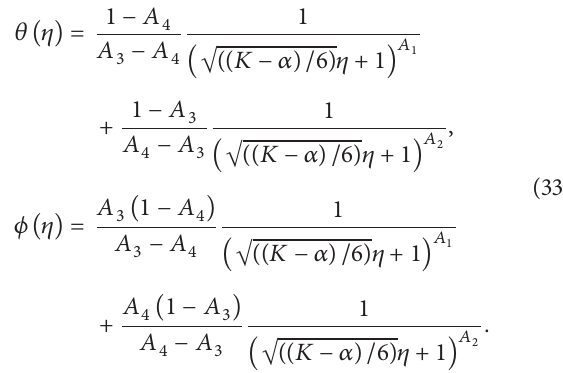
In order to match the boundary conditions at 𝜂 → ∞ , it is required that 𝐴 1 > 0 and 𝐴 2 > 0 , and 𝑐 0 = 0 , so (28)